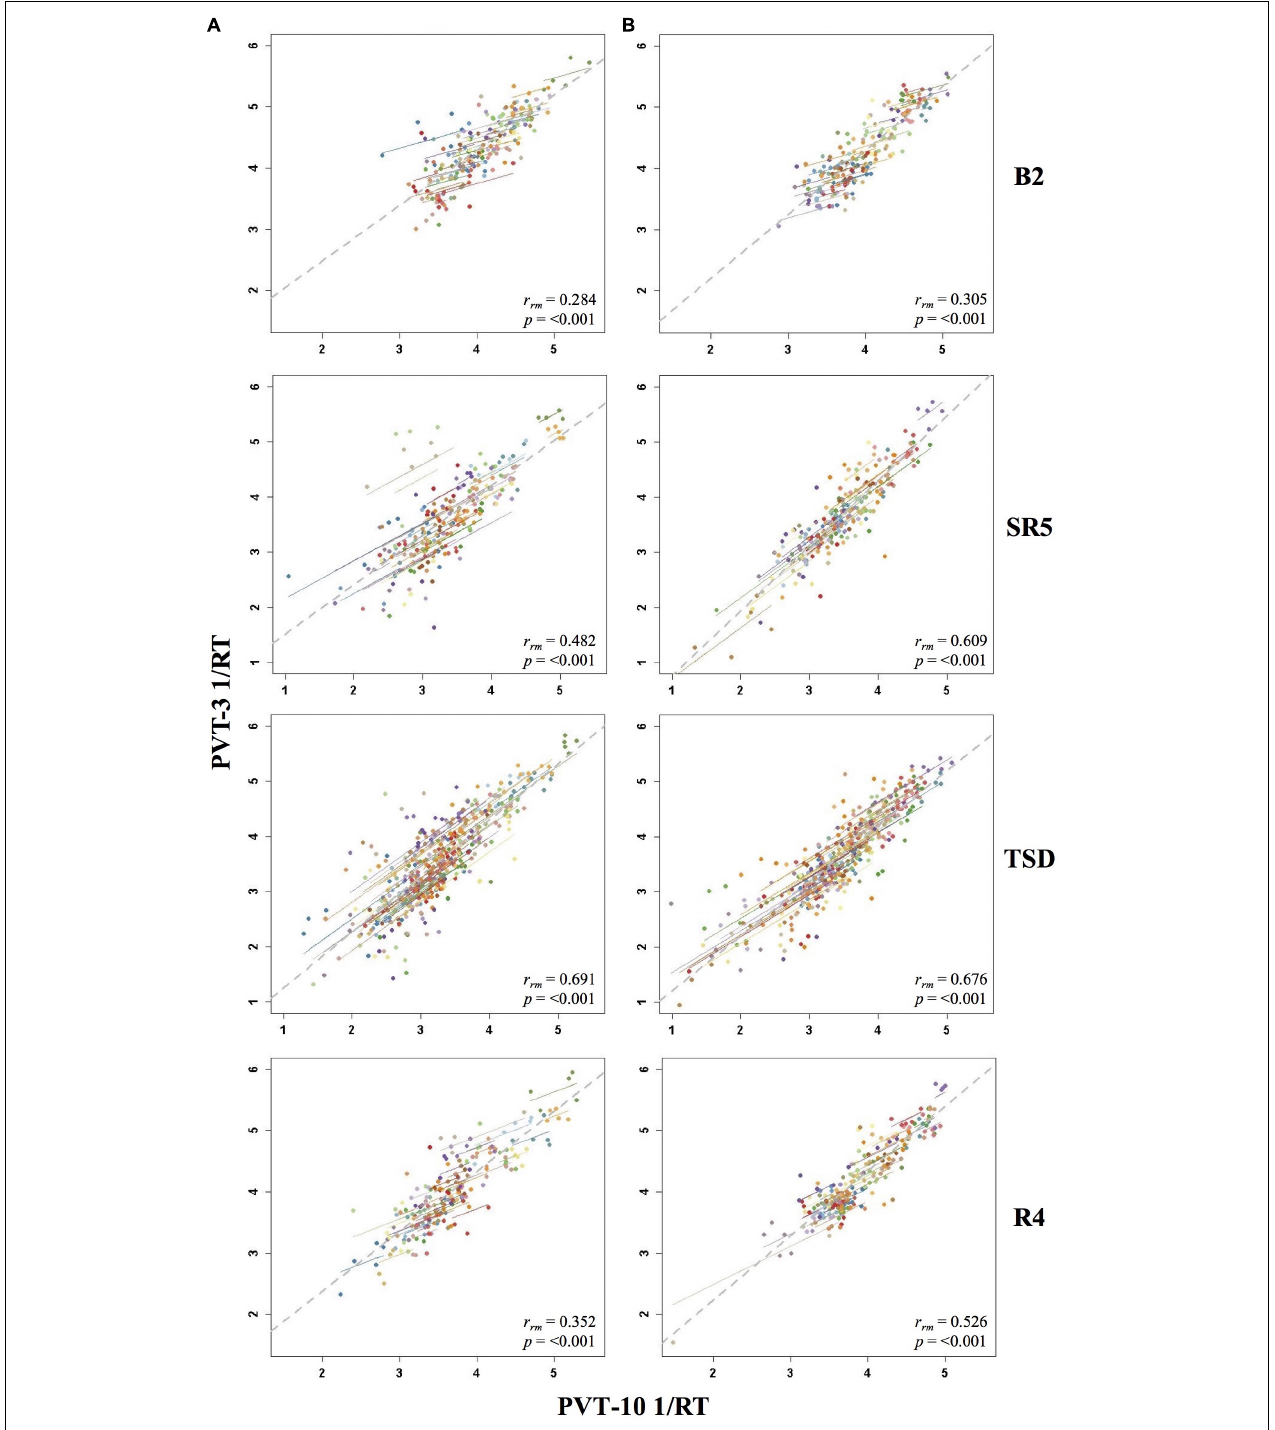
FIGURE 5 | Rmcorr plots of repeated-measures correlations between 10-min Psychomotor Vigilance Test (PVT-10) and 3-min Psychomotor Vigilance Test (PVT-3) response speed (1/RT) by study day for Condition A (A) and Condition B (B) . Each color represents a distinct participant with each point showing performance on both measures at one time point while the corresponding line shows the rmcorr fit for that participant (Bakdash and Marusich, 2020; R Core Team, 2020). The gray dashed line represents the regression line obtained by ignoring repeated measurements and treating the data as independent observations; r rm represents the common within-individual association (rmcorr). Rmcorr effect sizes were interpreted as follows: 0.00–0.29, negligible; 0.30–0.49, weak; 0.50–0.69, moderate; 0.70–0.89, strong; and 0.90–1.00, very strong. Included time points for each day were as follows: baseline day 2 (B2) from 1000 to 2200 h; sleep restriction day 5 (SR5) from 0800 to 2000 h; total sleep deprivation (TSD) from 2200 to 2000 h; and recovery day 4 (R4) from 1000 to 2000